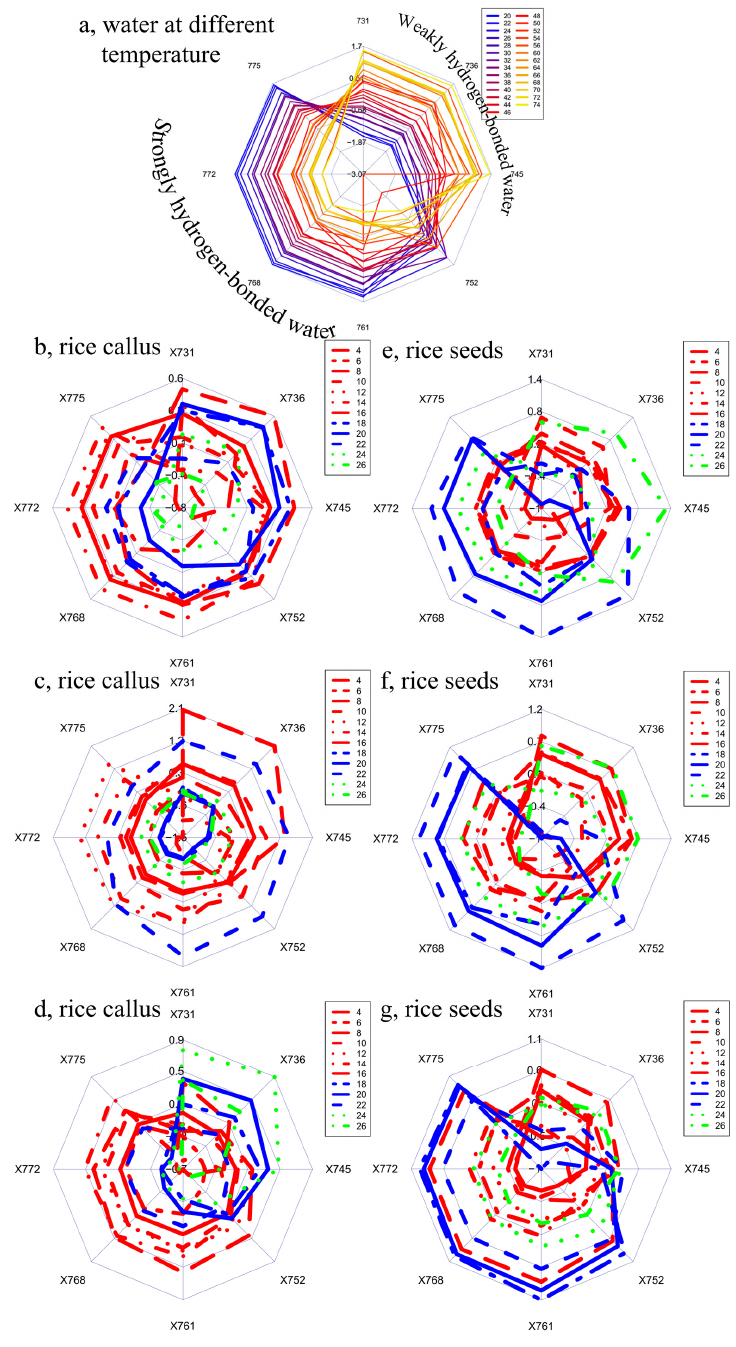
1 Figure 6. ( a ) Aquagrams of pure water in the 3rd overtone region, at different temperatures, showing fractions of weakly and strongly hydrogen-bonded water, respectively. The aquagram and water fractions are presented for the easier interpretation of the experimental findings, and the numbers in the legend present temperature in ◦ C. Plots ( b – g ) present the aquagrams calculated for selected wavelengths, showing the changes during cell development in the 3rd overtone region of water: ( b – d ) for the three clusters of callus and ( e – g ), for the three clusters of rice